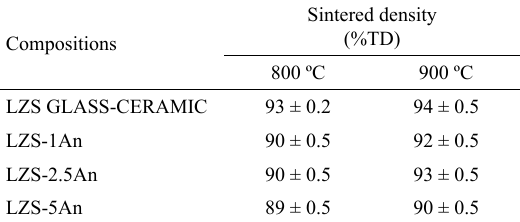
Table 2. Relative densities of samples sintered at 800 ºC and 900 ºC for 30